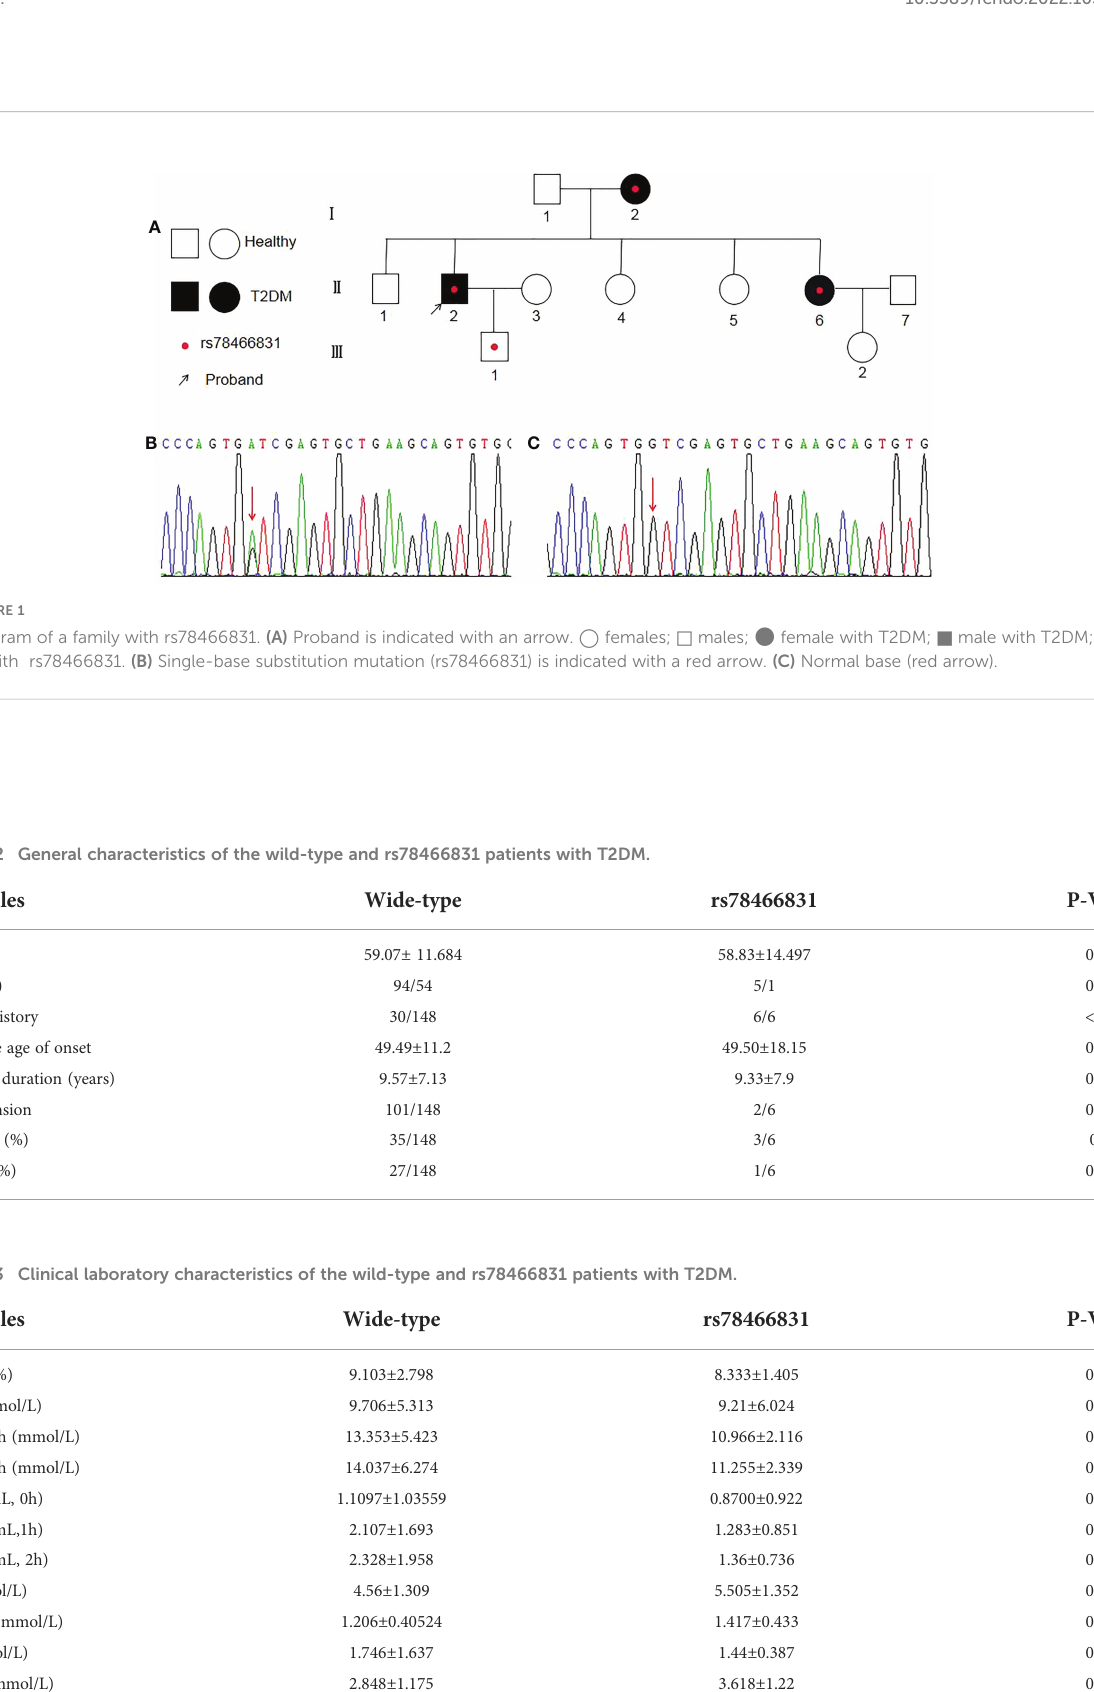
● female with T2DM; ■ male with T2DM;